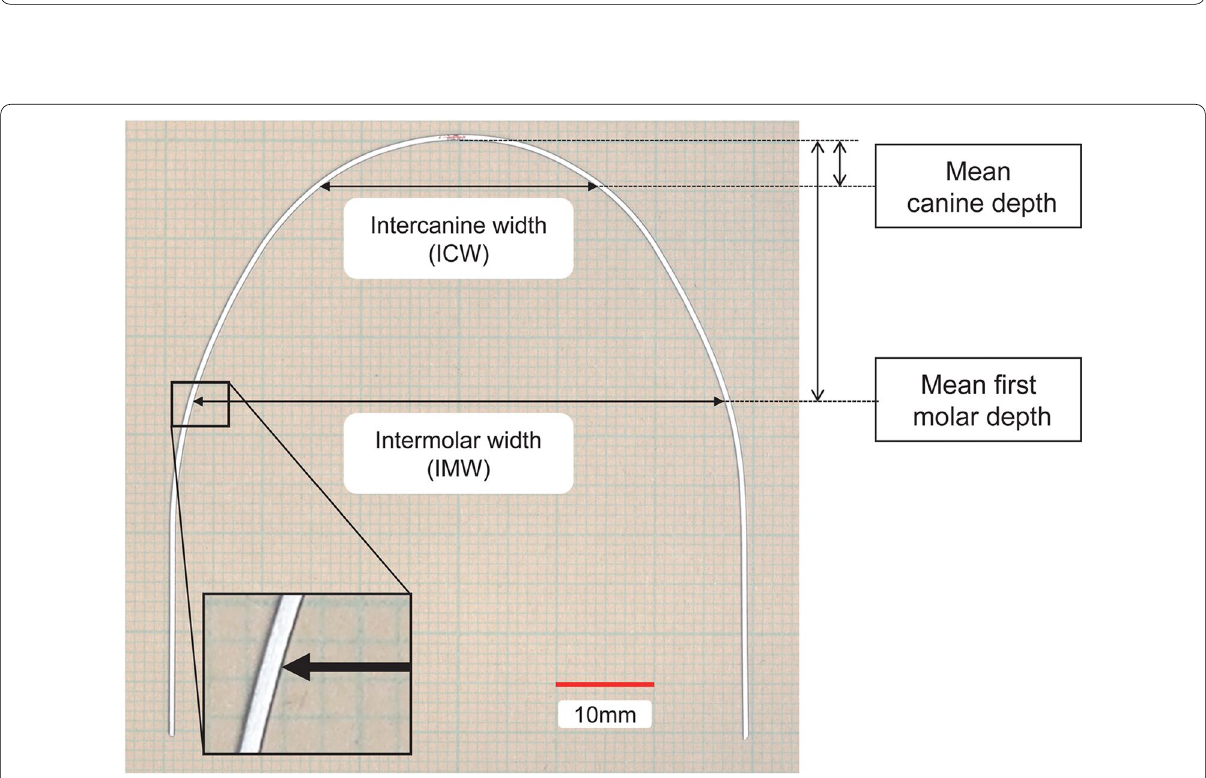
Fig. 2 Each archwire was placed on graph paper without fixation, and archwire widths were measured. (example: Orthos Arch Form Small 40 °C Cu-NT, ID: